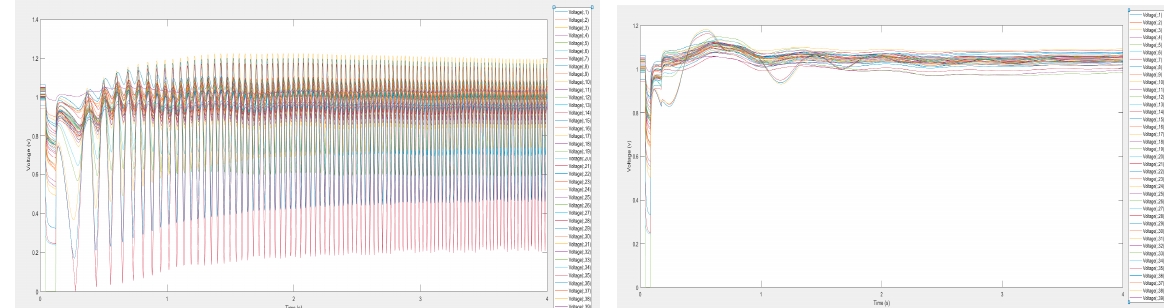
Figure 7. Comparison of voltage curve before and after collaborative transient stability control on fault lines 25–26 of IEEE 39 bus system.